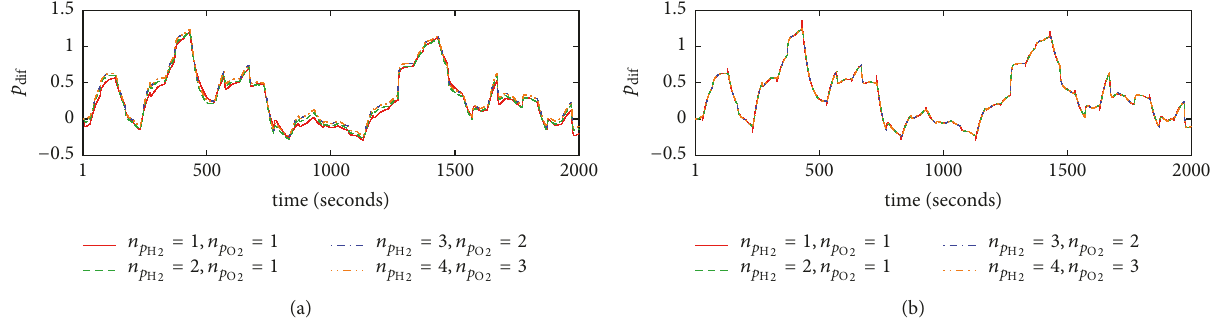
= 4 and 𝑛 = 3 ) models 𝑝 O 2 H 2